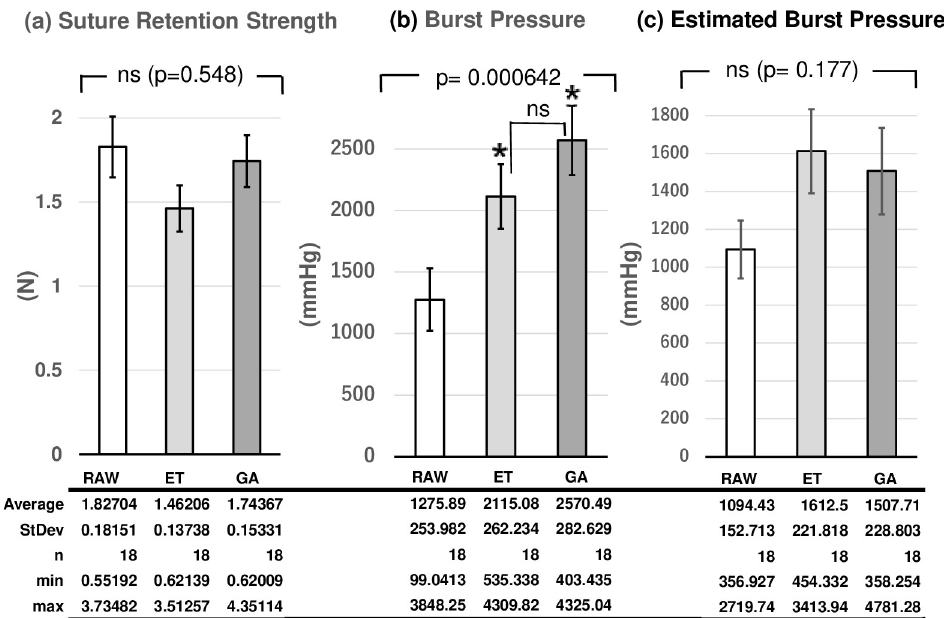
Fig 6. Suture retention strength (a), burst pressure (b) and the estimated burst pressure (c) of the three groups (RAW: group RAW, ET: group ET, GA: group GA, ns: no statistical differences. � Burst pressure of ET and GA groups were significantly higher than that of RAW